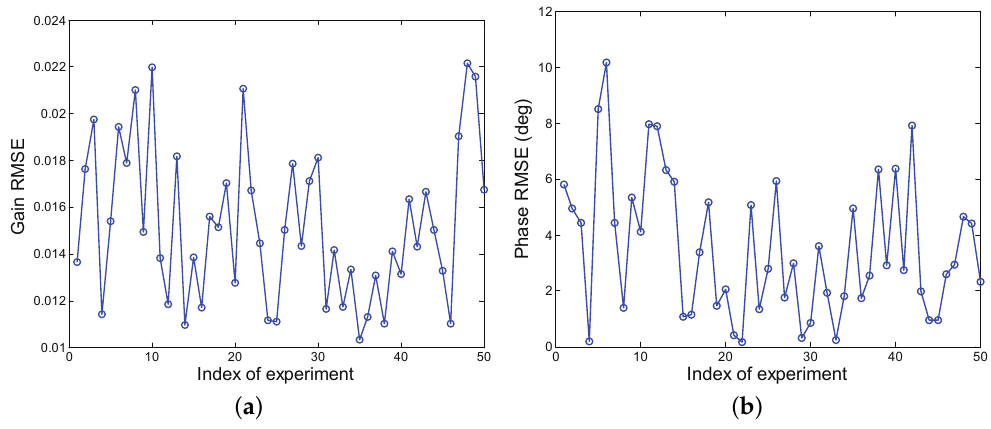
Figure 3. RMSEs of gain and phase errors versus different experiments, ( a ) gain error; ( b ) phase